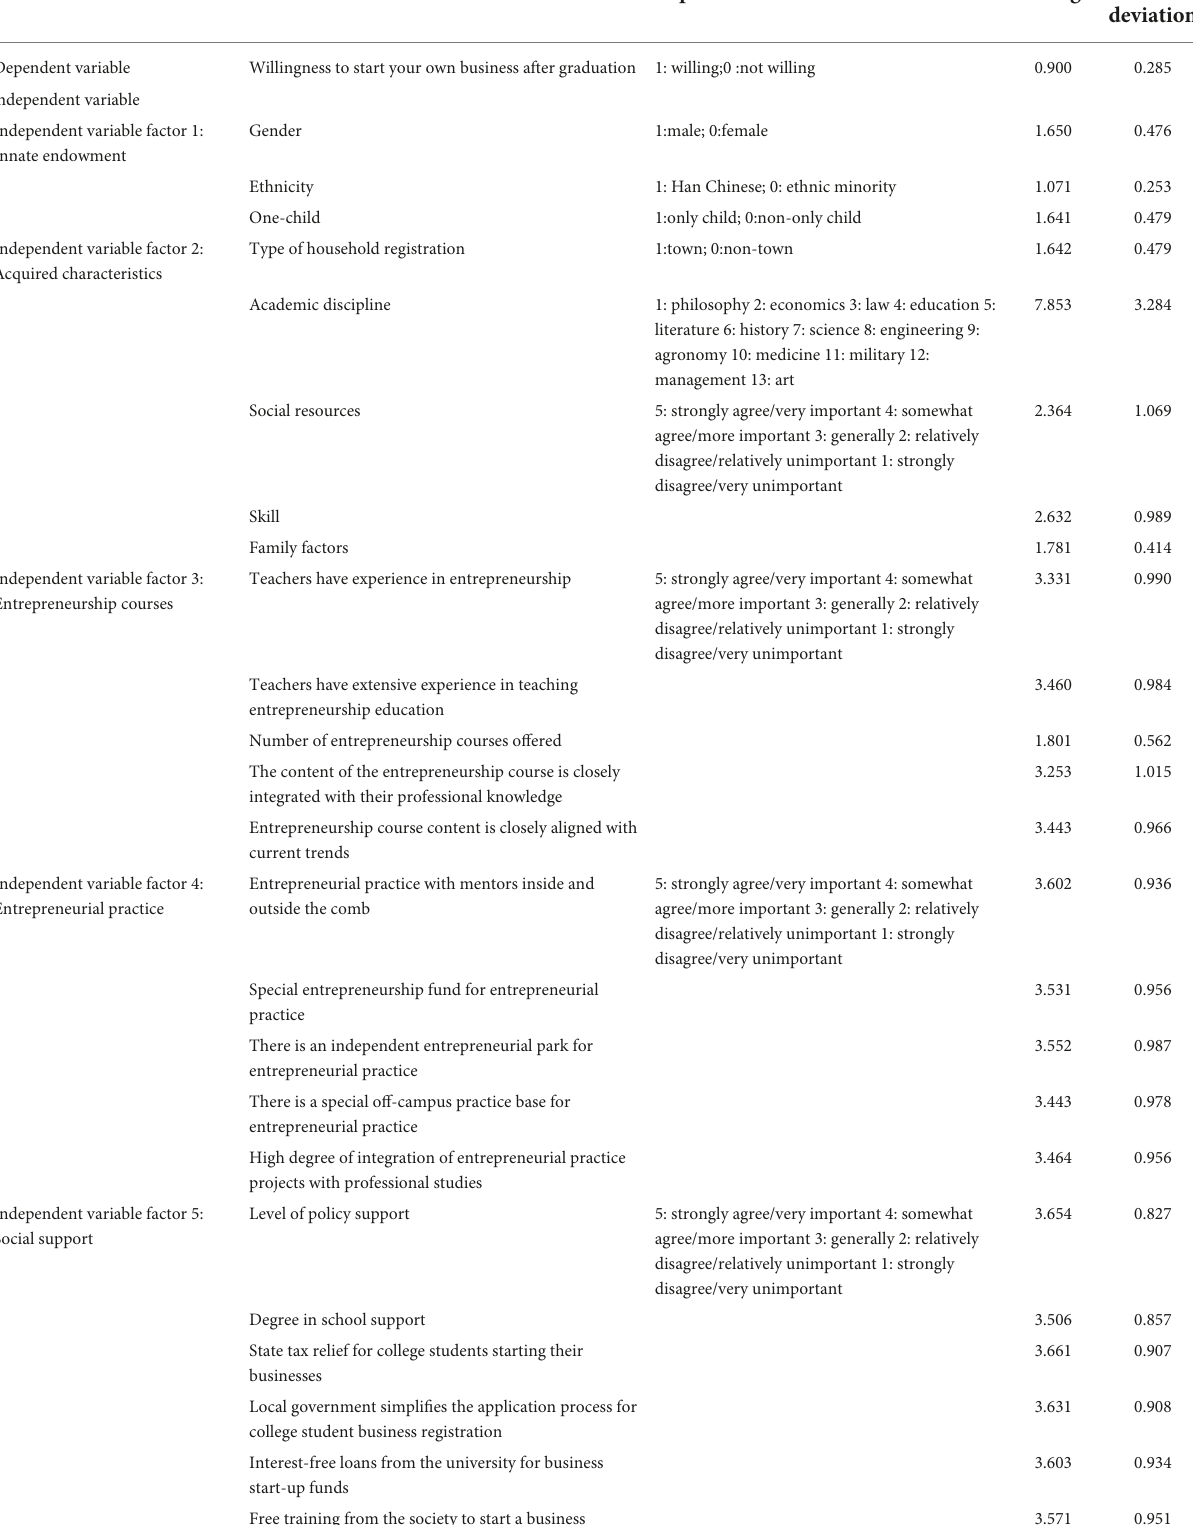
TABLE 2 Description of variables and descriptive results